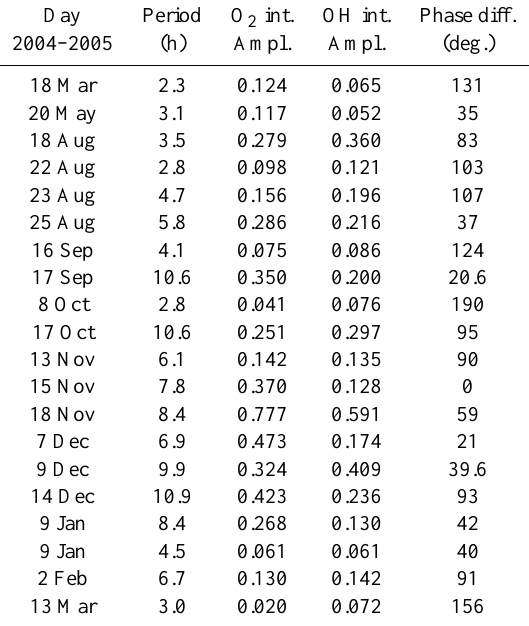
Table 1. O 2 b(0-1) and OH(6-2) intensity oscillation period, relative amplitude and phase difference between OH and O 2 for 20 wave events observed at Rikubetsu, Japan, in 2004–2005.